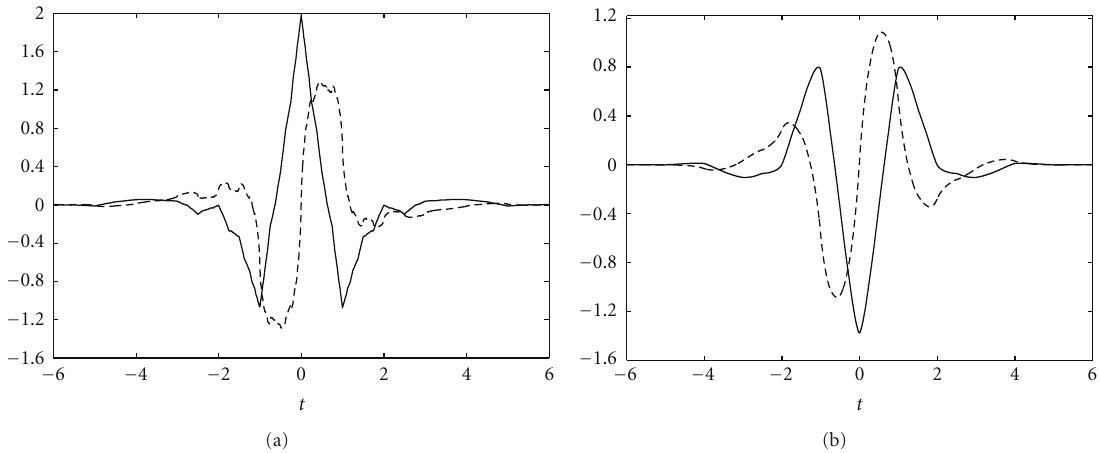
Figure 5: Wavelet bases in Example 2. (a) Decomposition wavelets: ψ h ( t ) of Antonini 9/7 wavelets (the solid line) and ψ g ( t ) of dual wavelets (the dashed line). (b) Reconstruction wavelets: (cid:2) ψ h ( t ) of Antonini 9/7 wavelets (the solid line) and (cid:2) ψ g ( t ) of dual wavelets (the dashed